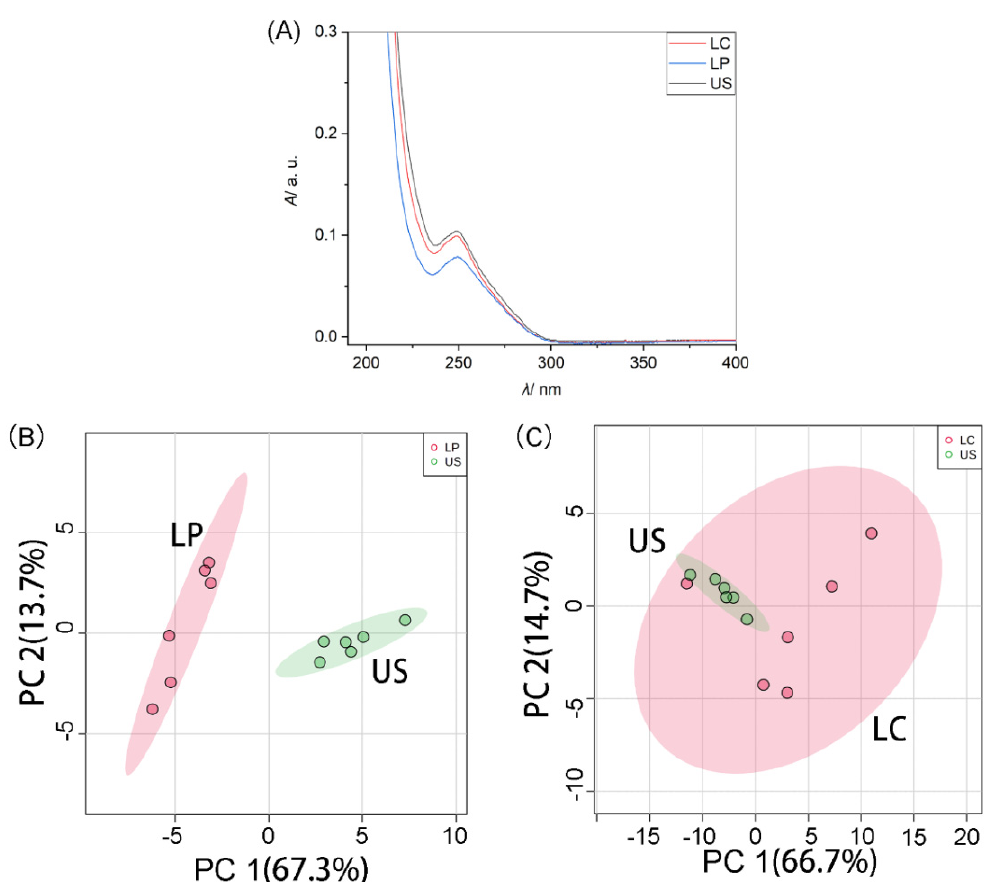
Figure 6. ( A ) UV-Vis spectra in the range 190–400 nm of extracts from the fish samples of Larimichthys crocea (LC), Larimichthys polyactis (LP) and unknown sample (US). ( B ) Plot of principal component analysis (PCA) scores for the UV-Vis spectra of fish species of LP and US. ( C ) Plot of PCA scores for the UV-Vis spectra of fish species of LC and US. The color-covered area displays 95% of confidence region. Six UV-Vis spectra were obtained from each species. The initial extract was diluted 80-fold for further analysis.